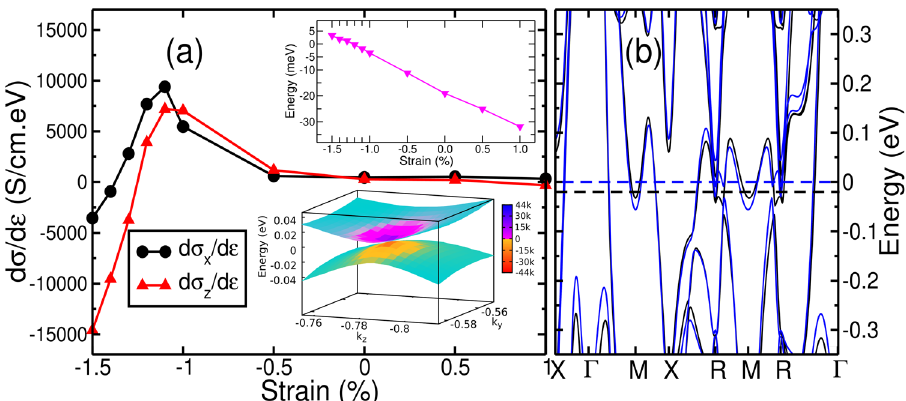
Fig. 5 Anomalous Nernst effect. a The calculated ANC of Mn 3 PdN in the Γ 4 g magnetic state. The Weyl points (0.43, − 0.35, − 0.49, and equivalent coordinates) shift across the Fermi level with strain (inset above) and the Berry curvature for the 1.4% compressive biaxial strain (inset below). b The band structure of Mn 3 PdN for unstrained (black) and 1.4% compressive biaxial strained (blue). The presence of Weyl point near the Fermi energy is indicated by black (cubic) and blue dashed line ( − 1.4% biaxial